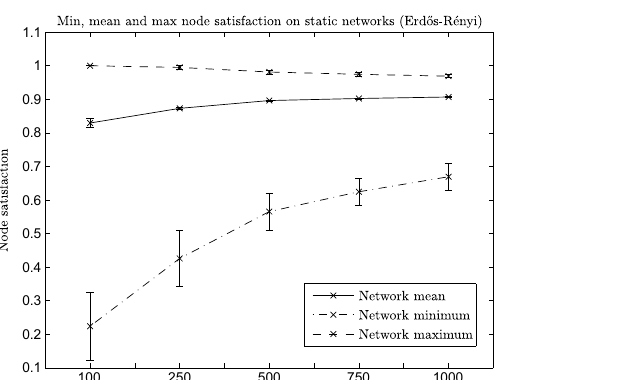
Figure 8. Satisfaction per network size.